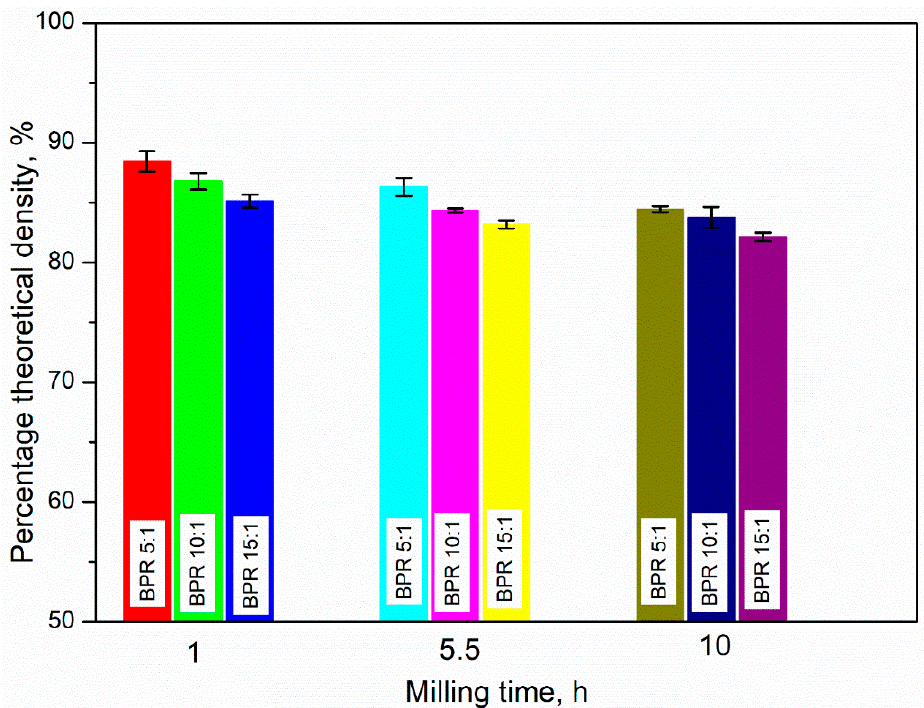
Figure 9. Variation in percentage theoretical density with the milling time and BPRs for FeMn 30 Cu 5 biodegradable alloys. Table 3. Variation of milling times and ball-to-powder ratios on percentage theoretical density, Vickers hardness strength, and mechanical